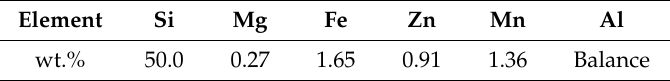
Chemical composition of silicon particle-reinforced aluminum matrix composites (Si p / Al MMCs) (in